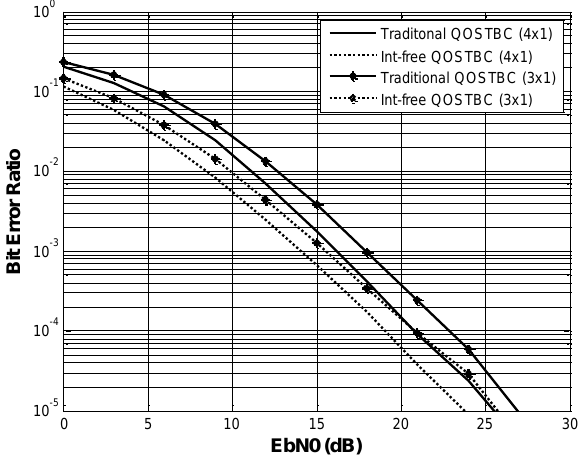
Figure 4: Comparison of Standard and Interference-free (Int- free) QOSTBC